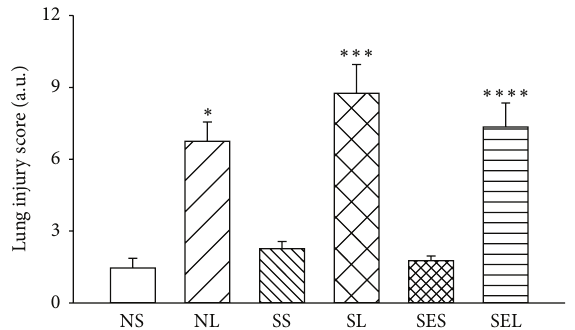
Figure 7: The lung injury score in different groups after LPS administration. Data are expressed as mean ± S.E.M. ∗ 𝑃 < 0.05 , compared with the NS group; ∗∗∗ 𝑃 < 0.05 , compared with the SS group; ∗∗∗∗ 𝑃 < 0.05 , compared with the SES group (one-way ANOVA).